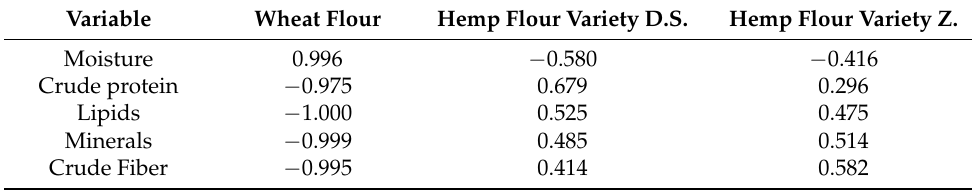
Table 2. Pearson correlation for physicochemical properties of flour sample. Variable Wheat Flour Hemp Flour Variety D.S. Hemp Flour Variety Z. Moisture 0.996 −